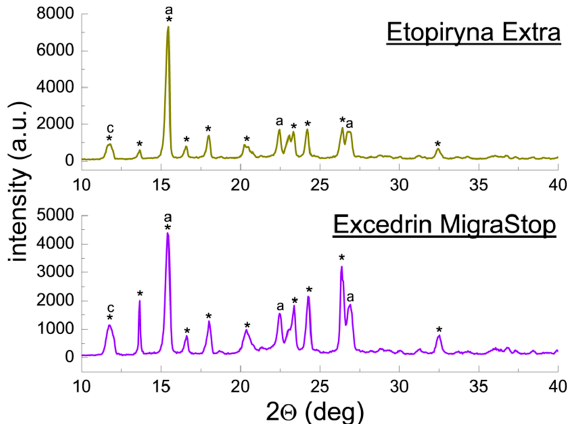
Figure 7. Diffraction patterns for the drugs Etopiryna Extra and Excedrin Migra Stop. (* - acetaminophen, a – acetylsalicylic acid, c – caffeine). Table 5. Comparison of experimental data with data from the ICDD database for the drugs Etopiryna Extra and Excedrin MigraStop containing ACP (C 8 H 9 NO 2 ), ASA (C 9 H 8 O 4 ) and caffeine (C 8 H 10 N 4 O 2 ). No. of Di ff raction